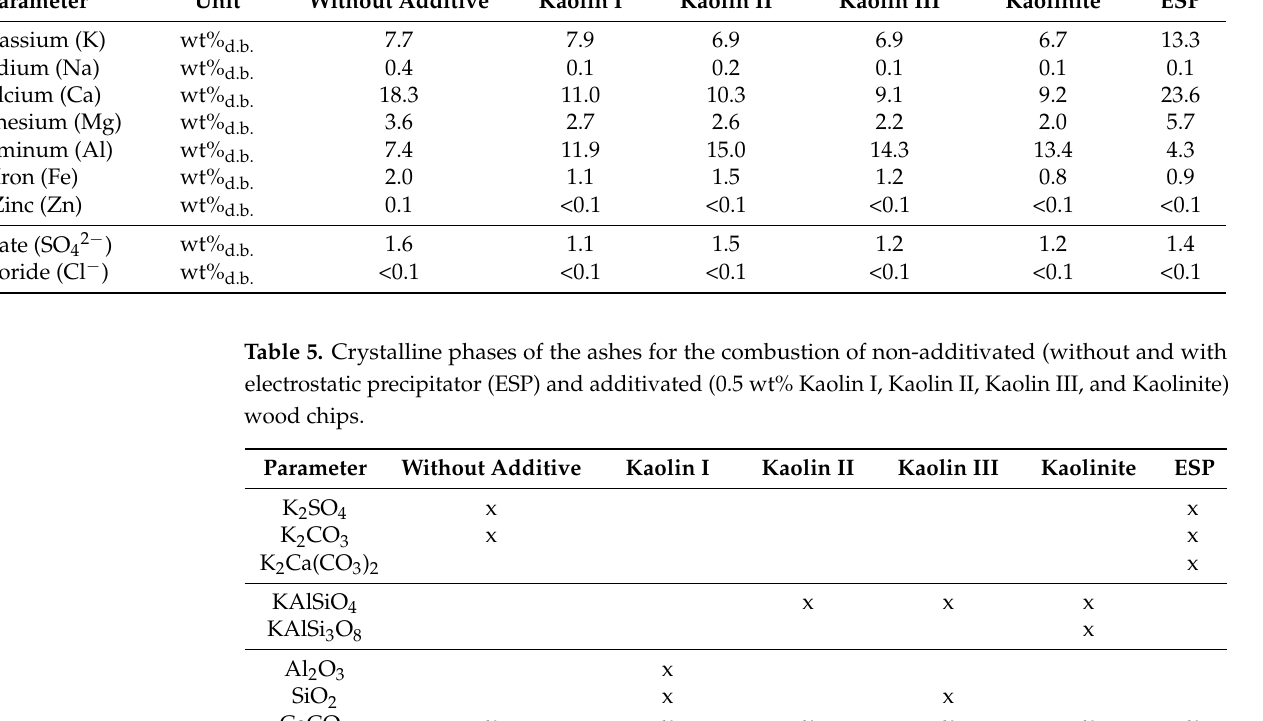
Table 4. Chemical compositions of the ashes for the combustion of non-additivated (without and with electrostatic precipitator (ESP)) and additivated (0.5 wt% Kaolin I, Kaolin II, Kaolin III, and Kaolinite) wood chips (d.b.: dry ash basis).